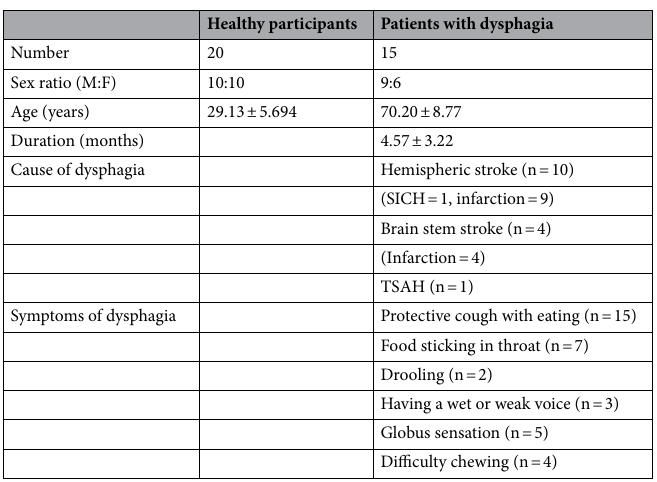
Table 1. Characteristics of participants. Mean ± standard deviation, M:F, male:female; TSAH, traumatic subarachnoid hemorrhage; SICH, spontaneous intra-cerebral hemorrhage. Food sticking, cough with eating, globus sensation, or diet